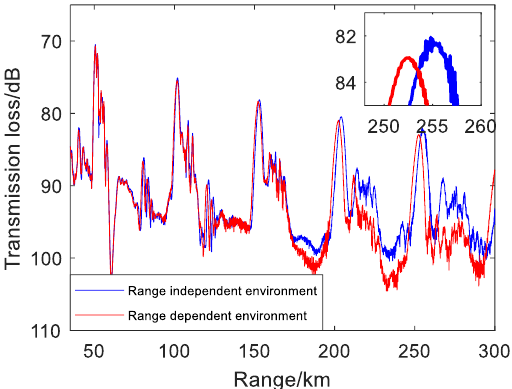
Figure 15. Transmission loss obtained from range-independent and range-dependent sound speed profiles with source and receiver depths of 200 m.